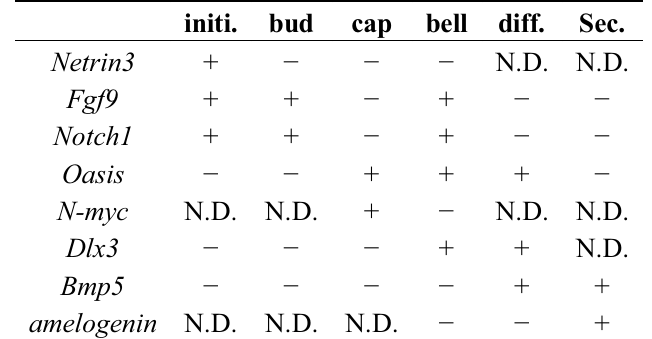
Table 5. Summary of gene expression pattern in the inner enamel epithelium at developmental stages ( in-situ hybridization [38]) initi. bud cap bell diff. Sec. Netrin3 N.D. N.D. Fgf9